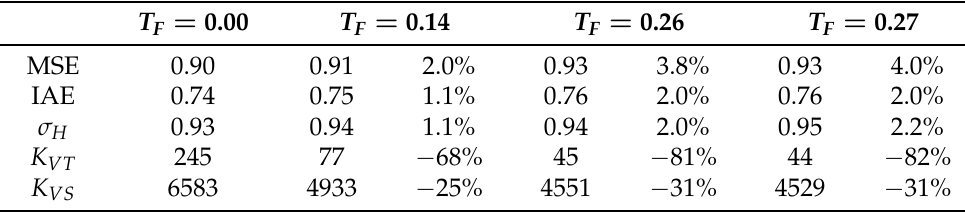
Undisturbed and noisy CPA indicators are calculated and sketched in Table 12. Time trends are qualitatively similar for all plants, and they are not further shown. Similar to the previous G 1 ( s ) case, MSE is not aiming at the noises, while IAE focuses at the steady-state noisy operation. As in the previous case, the noise has a significant impact on both actuator valve travel indexes K VT and K VS . Table 12. G 2 ( s ) CPA indexes.